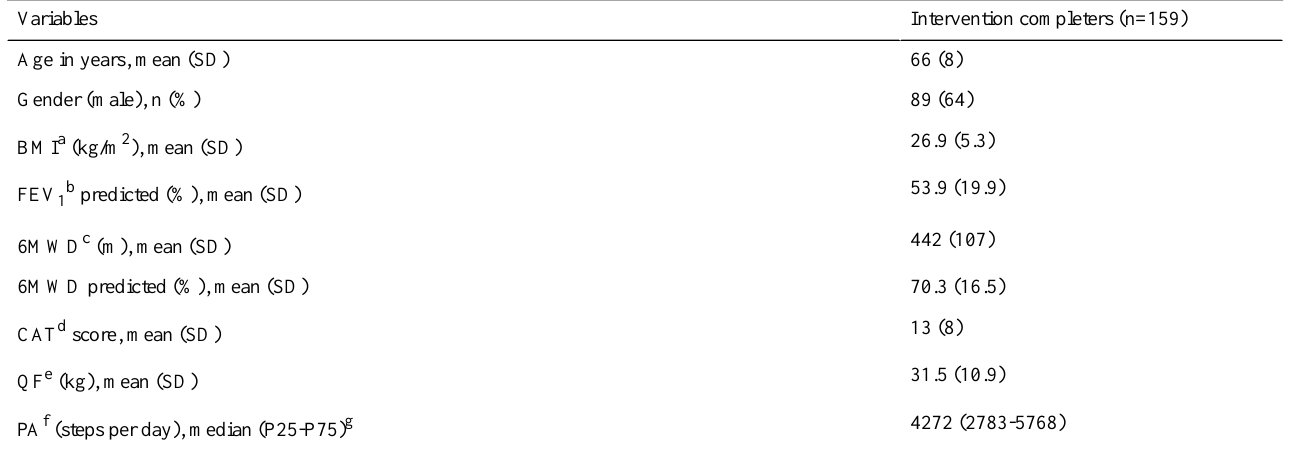
Table 1. Baseline characteristics of the completers of the trial.